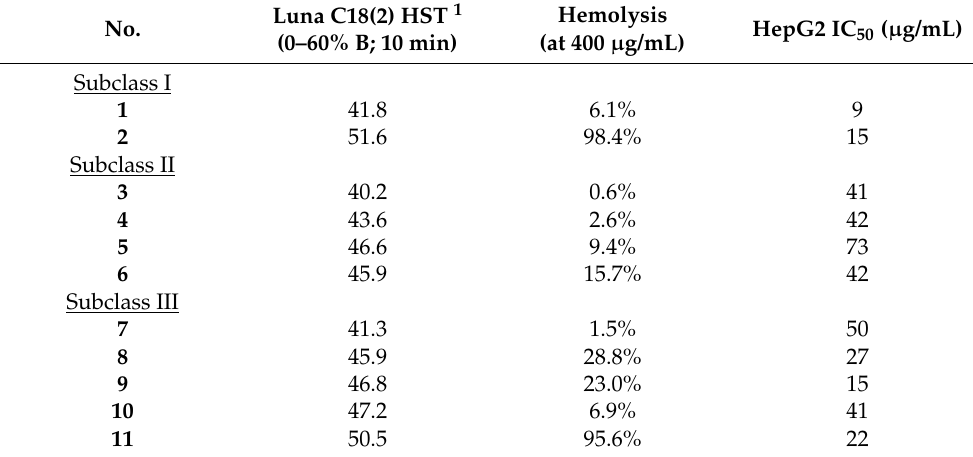
Table 3. Correlation between hydrophobicity and effect on cellular